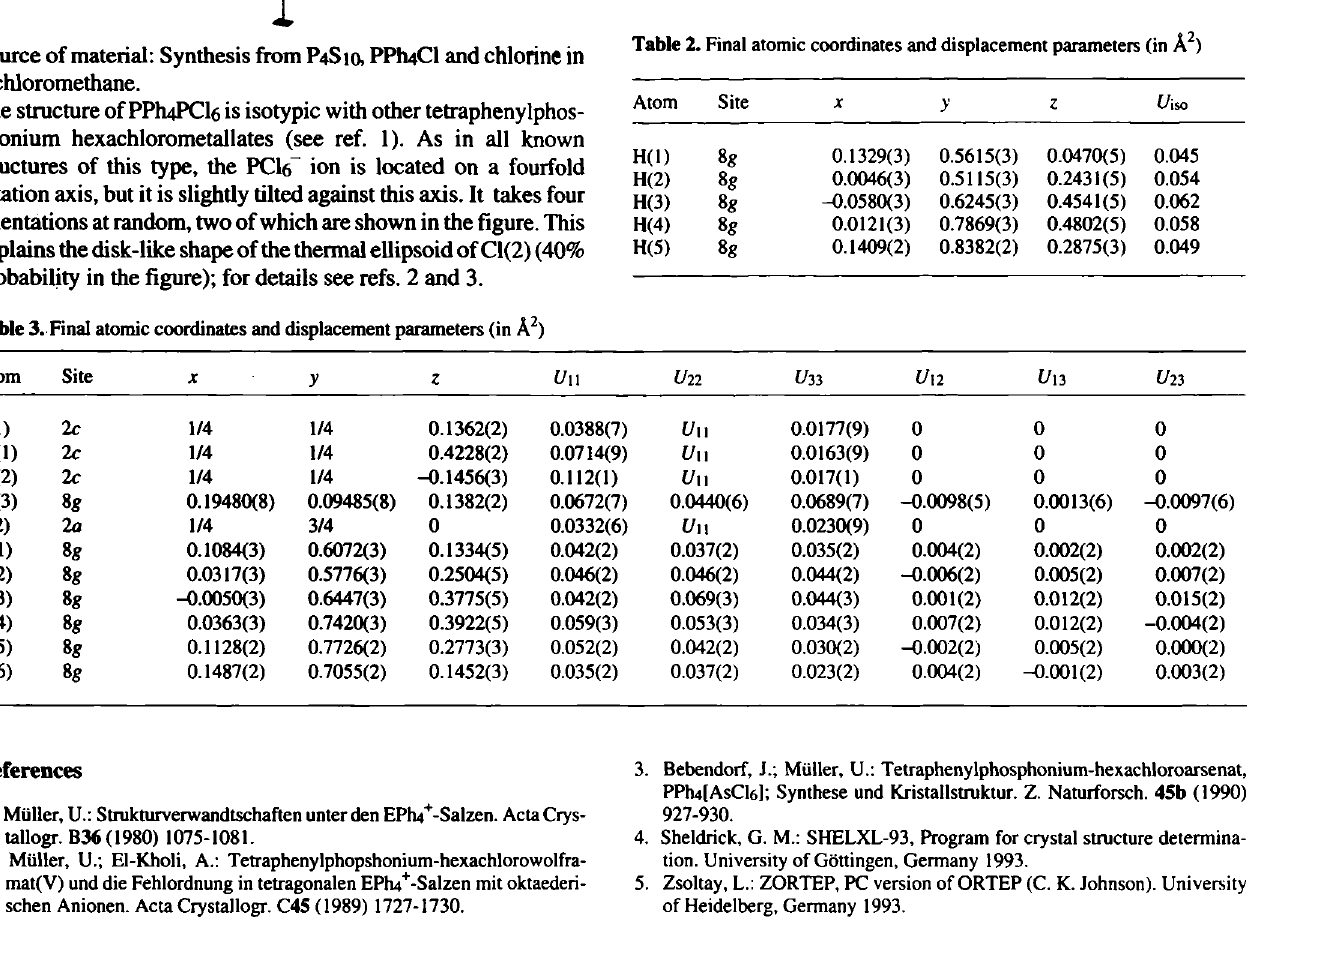
Table 1. Parameters used for the X-ray data collection Crystal: